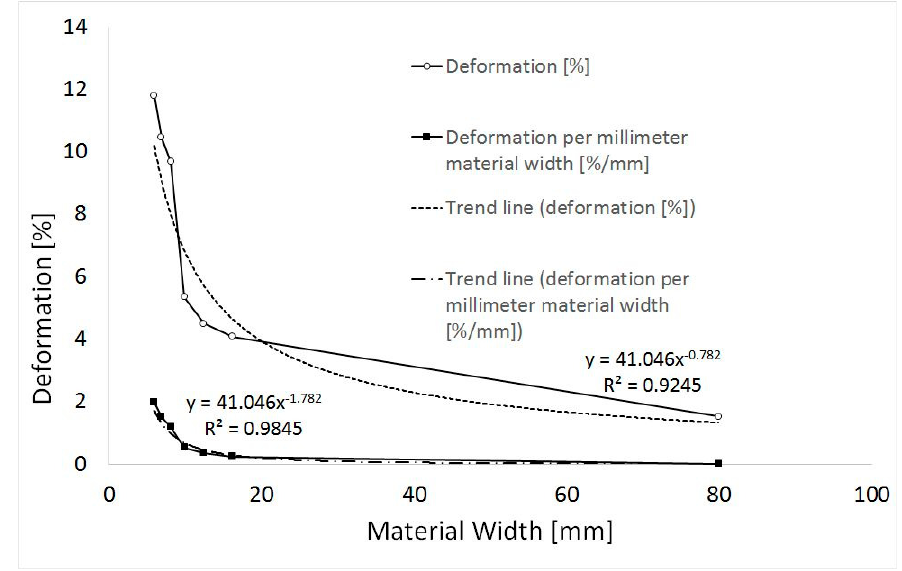
Figure 2. Relation between material width and percentage of deformation at a constant height.